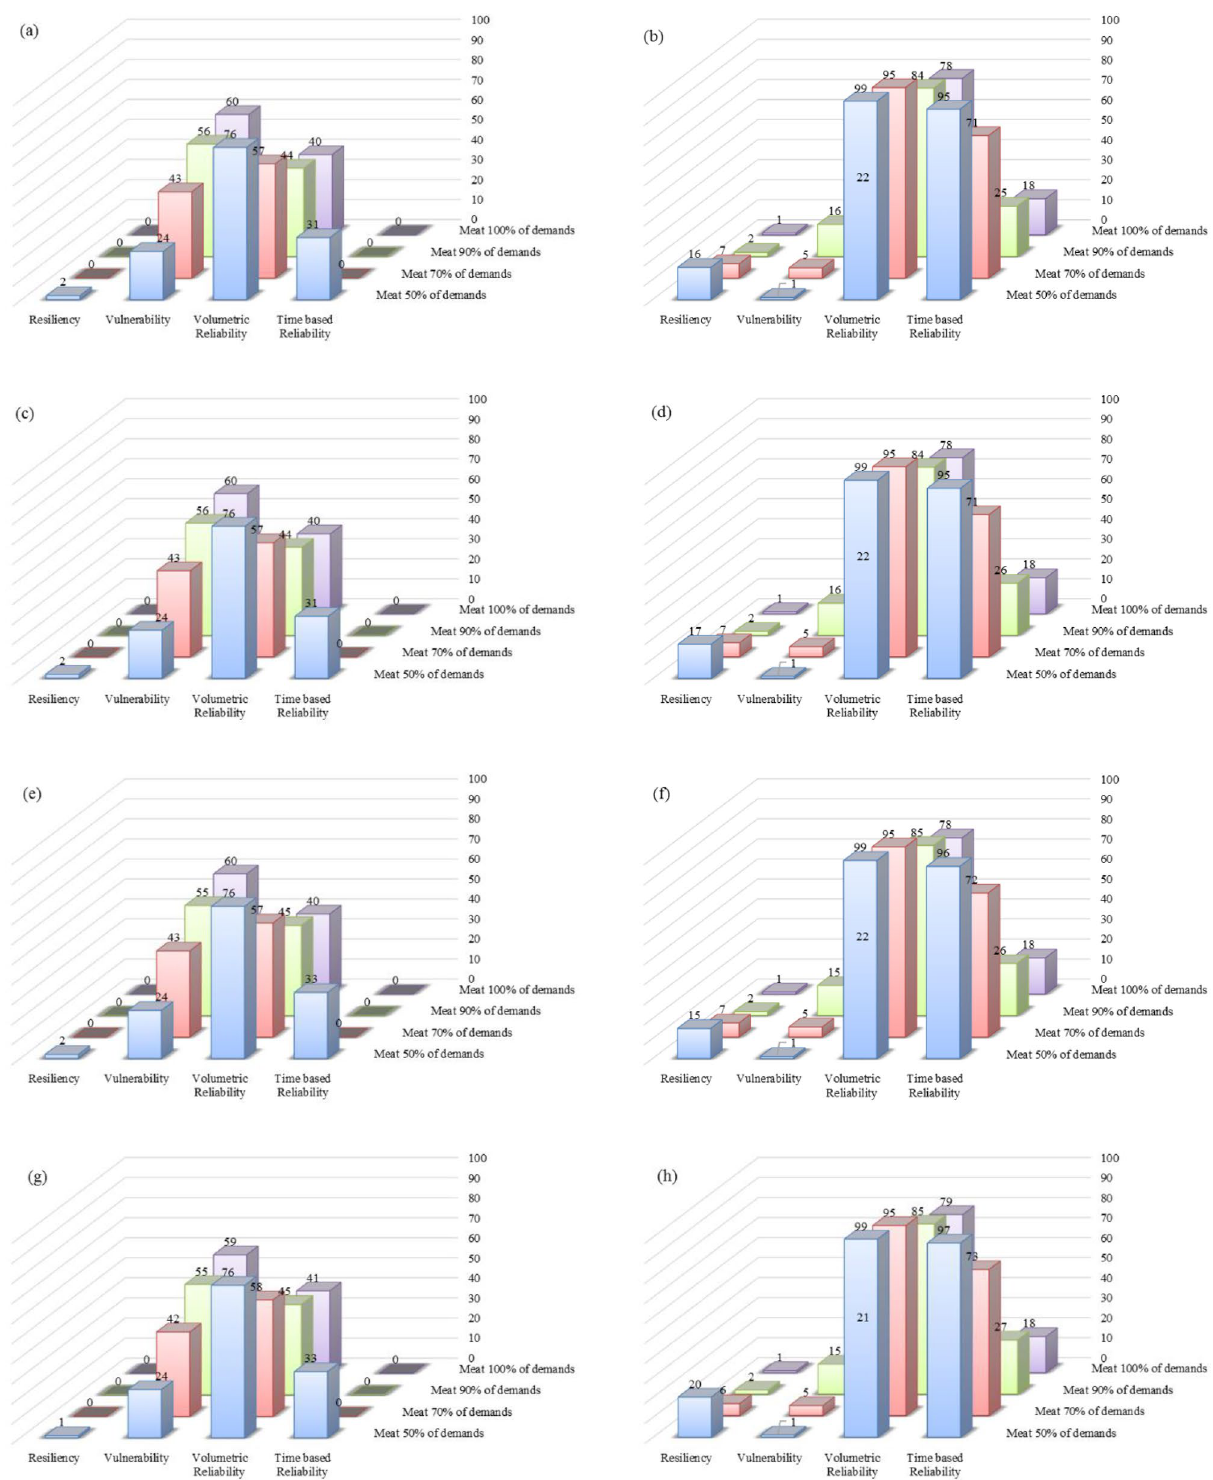
Figure 10. Performance criteria of the predicted lake volumes in future periods for Option 1 under six management scenarios: ( a ) management Scenario 1 in 2021–2050; ( b ) management Scenario 1 in 2051–2080; ( c ) management Scenario 2 in 2021–2050; ( d ) management Scenario 2 in 2051–2080; ( e ) management Scenario 3 in 2021–2050; ( f ) management Scenario 3 in 2051–2080; ( g ) management Scenario 4 in 2021–2050; ( h